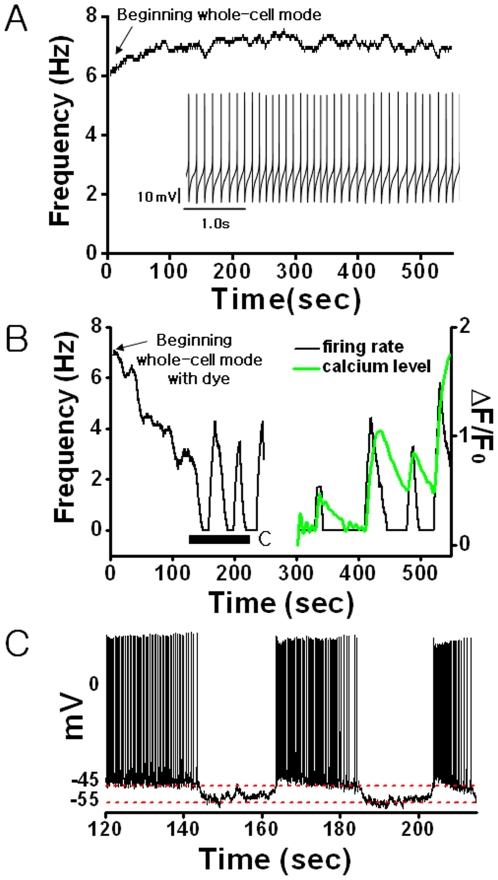
The loading effect of fluo-4 Ca2+indicator dye on the AP firing activity of a SCN neuron:(A) A typical spontaneous firing pattern and the time trace of mean firing rate of a SCN neuron in an acute rat hypothalamic slice. (B) The time trace of mean firing rate (black) and the level of [Ca2+]c (green) of a SCN neuron following the fluo-4 AM dye injection (100 µM). The mean firing rate is computed based on a 10-second sliding window. The time “0” denotes the onset of the whole-cell mode. (C) Time series of AP spiking activities during the fluo-4 AM dye loading as marked in B. The red dashed lines guide the resting membrane potential.